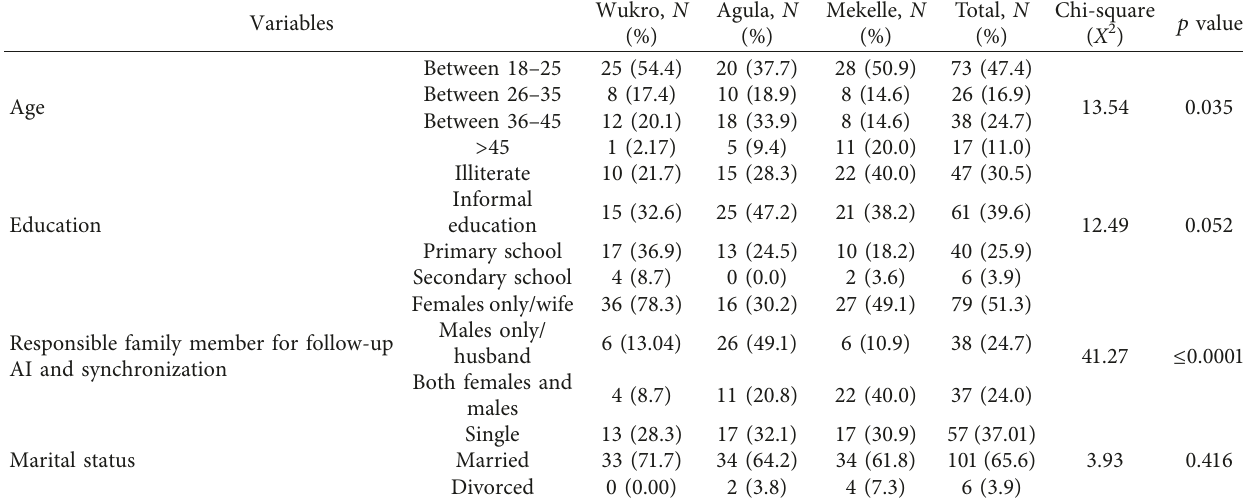
Table 2: General household characteristics of the respondents in the study area.